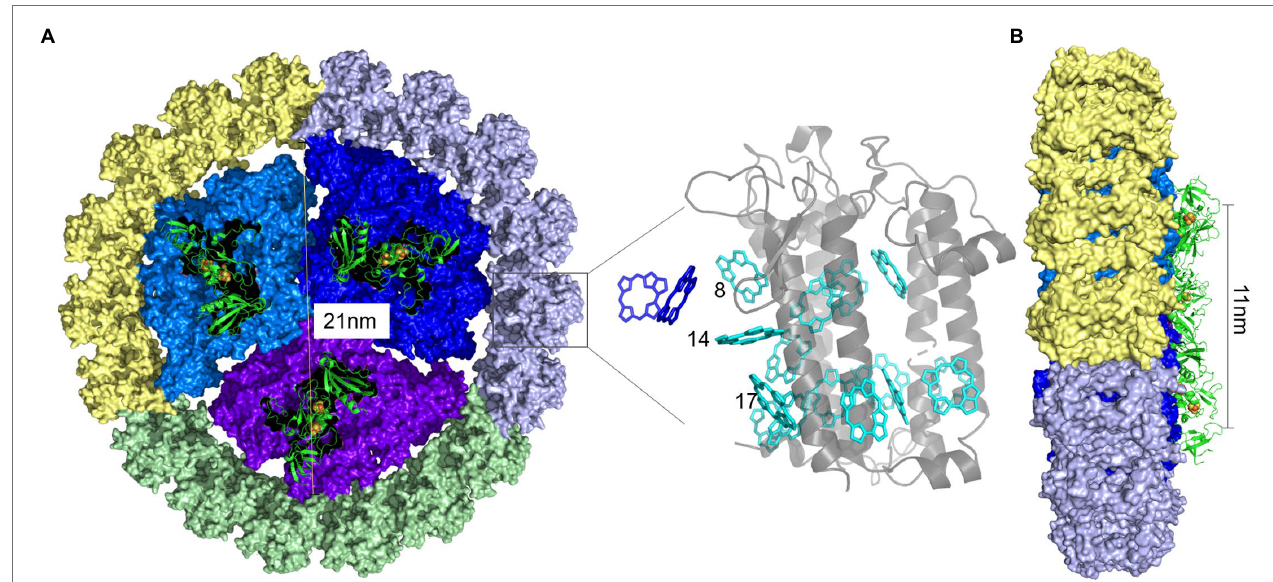
FIGURE 2 | PSI-IsiA supercomplex structure (Drawn according to the study by Toporik et al. (2019) and Cao et al. (2020). A. The IsiA18 –PSI trimer supercomplex structure. 18 IsiA monomers form a ring around the PSI trimer. PSI monomers were colored in blue, dark blue and purple, respectively. 6 IsiA proteins surrounding each PSI monomer were colored grey, green and yellow, respectively. The diameter of PSI trimer is 21 nm, and the distance between two adjacent highest positions of PSI monomers in PSI trimer is 11 nm (B). Chlorophylls around IsiA is cyan, and the Chlorophylls near the PSI trimer is dark blue. Grey is the IsiA